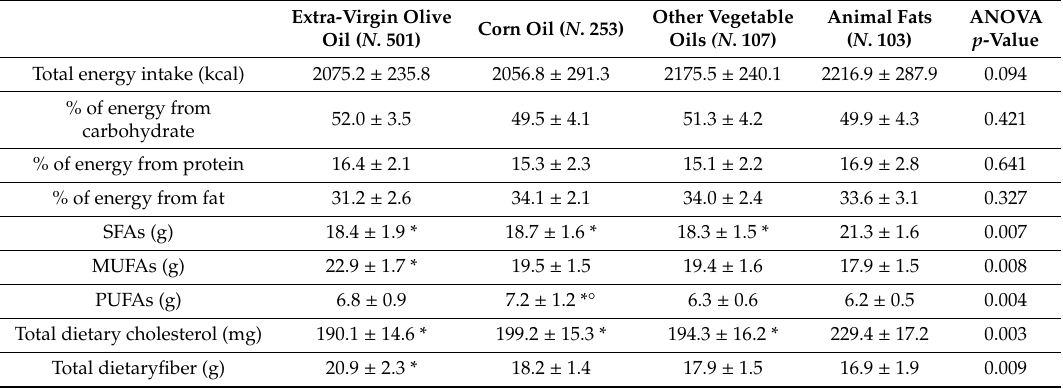
Table 2. Main diet composition characteristics of subjects consuming di ff erent predominant cooking fats in everyday